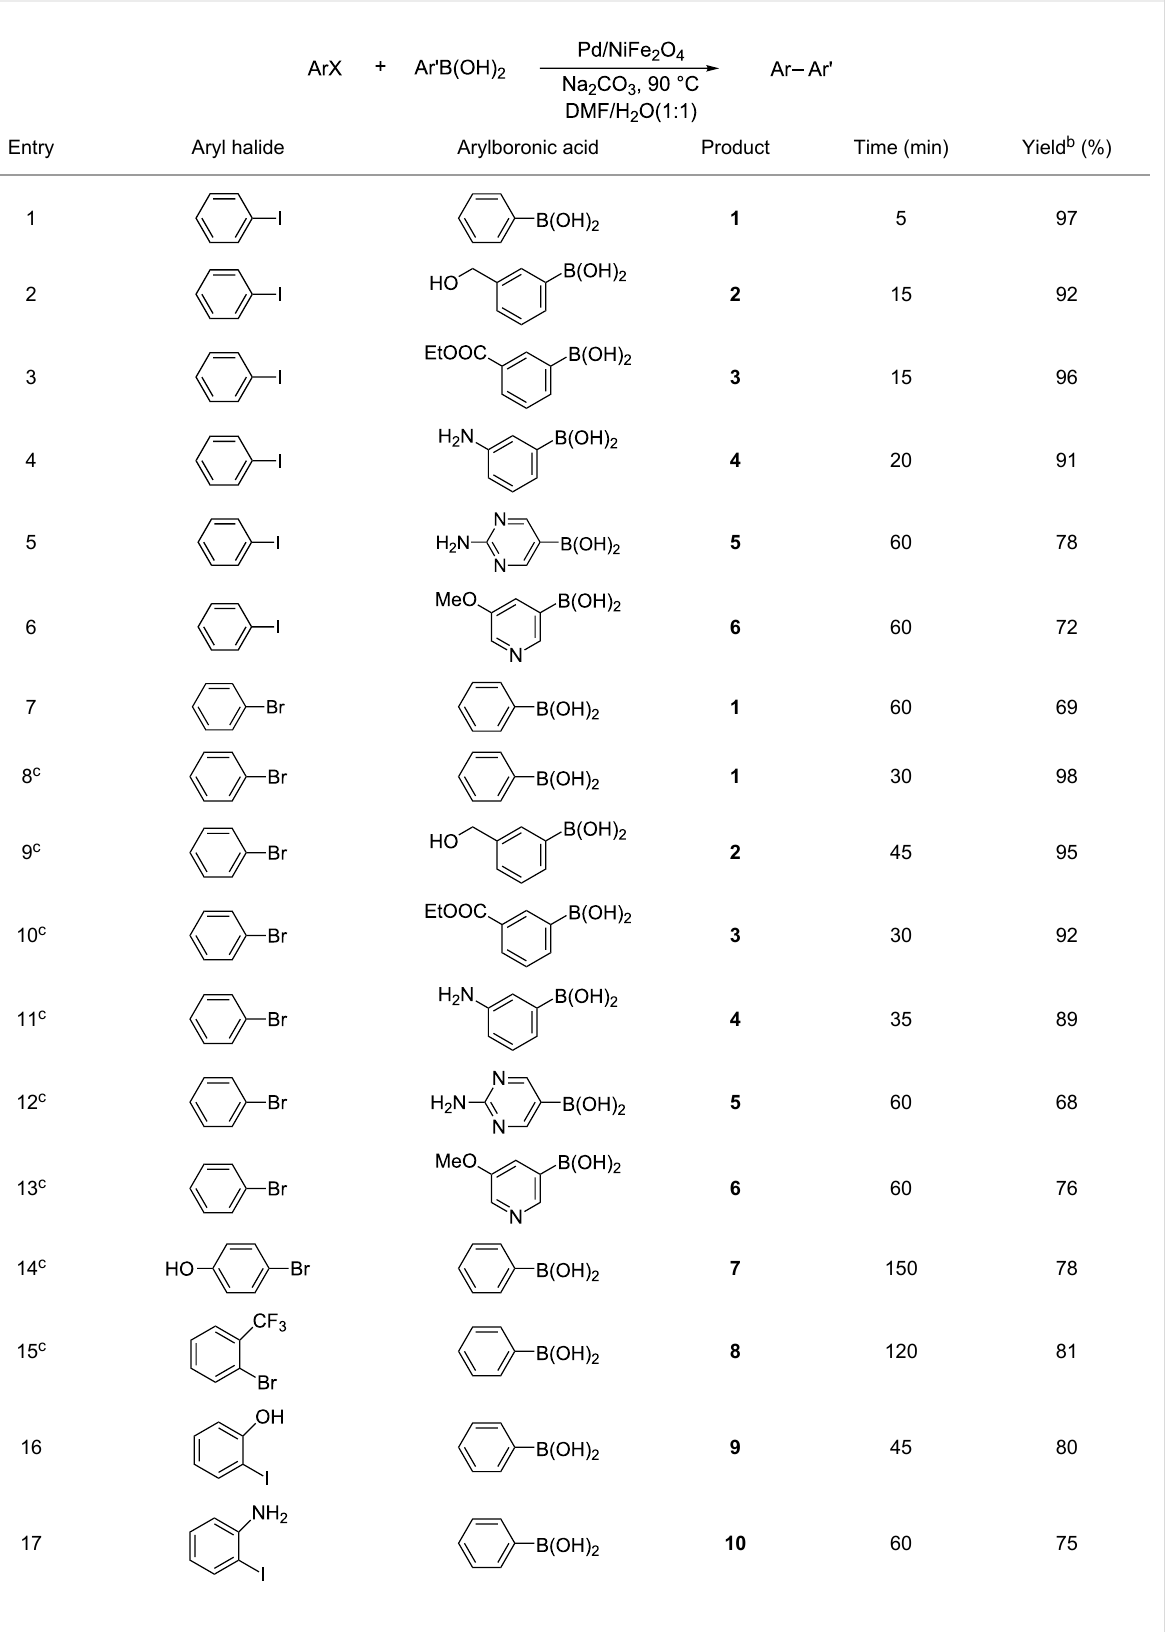
Table 4: Suzuki cross coupling reaction of aryl halides with arylboronic acid a